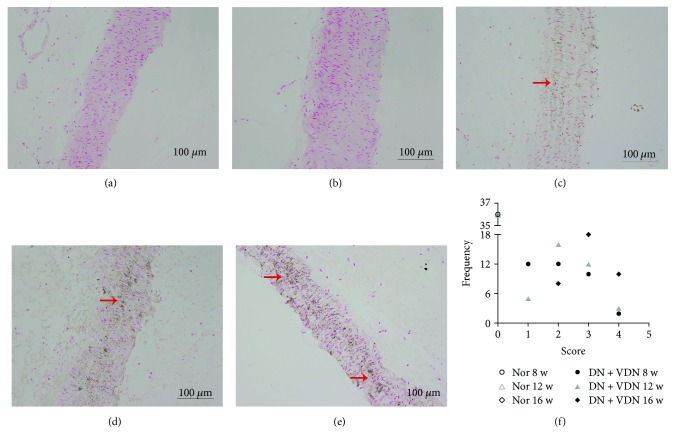
Histological analysis of aortic calcification with von Kossa staining. The von Kossa staining of aortic tissues from normal rats and DN + VDN rats. No deposition of calcium salts was observed in aortic tissues of normal rats at 8 (a) and 16 weeks (b). In contrast, rats in the DN + VDN group exhibited scattered, punctated deposition of calcium salts in the form of dark brown granules interspersed with the elastic fibers in arterial intima-media at the end of the 8th week (c); and a large quantity of aggregated deposits of calcium salts in vascular wall at the end of the 12th week (d); and finally formed a wide area of confluent calcification plaque at the end of the 16th week (e). (f) rats in the DN + VDN group had significantly higher vascular calcification scores than those of normal rats at 8, 12, and 16 weeks (p < 0.001). Data presented as mean ± standard deviation (SD). Nor group: normal controls; DN + VDN group: diabetic nephropathy rats with vitamin D3/nicotine-induced vascular calcification.